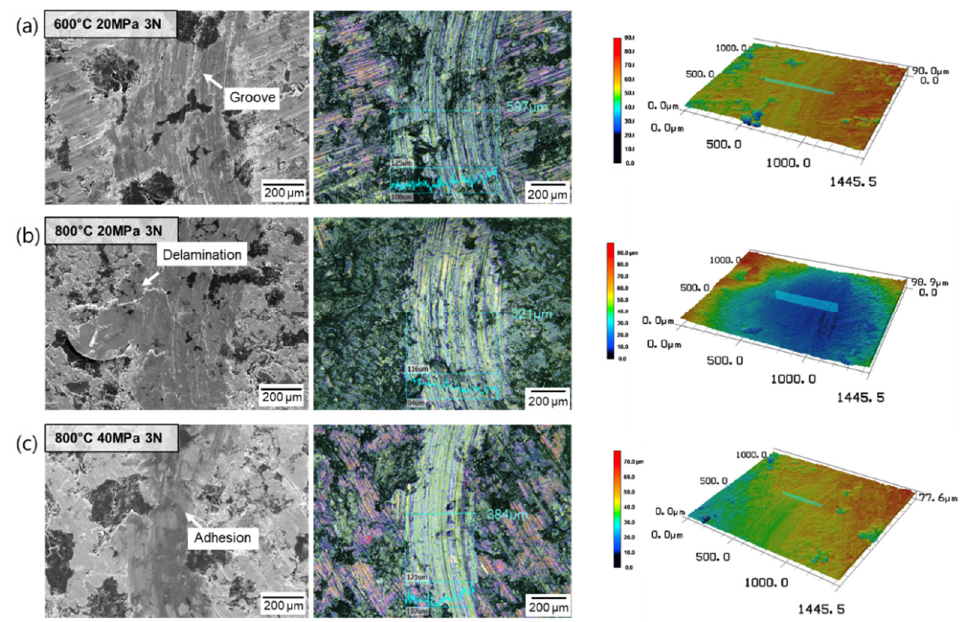
Figure 7. BSE images (left), confocal images (center), and 3D images (right) of worn surfaces of ( a ) 600-20, ( b ) 800-20, ( c ) 800-40 samples.